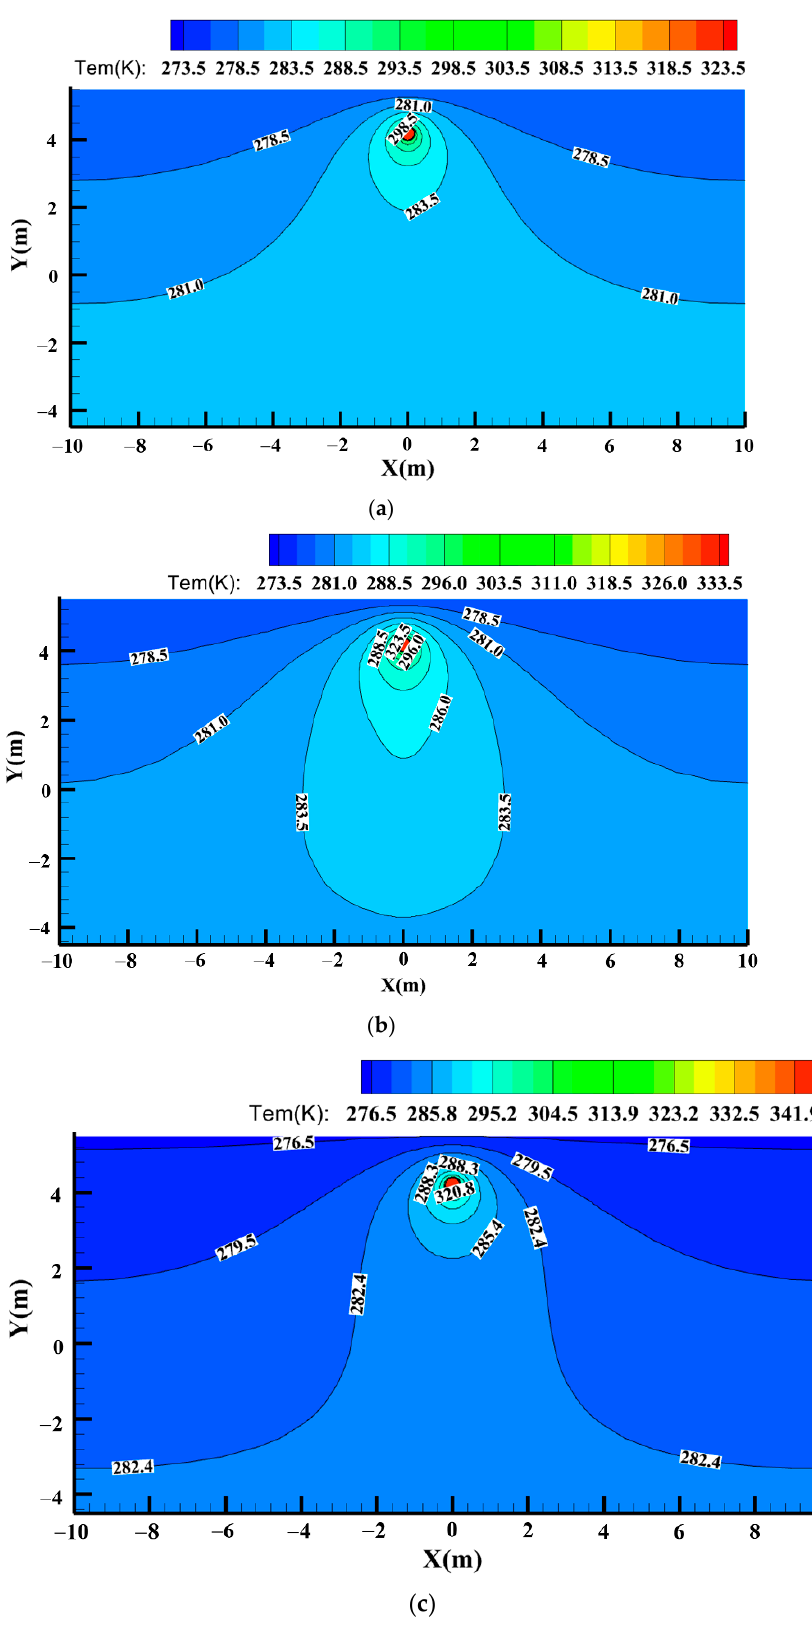
Figure 9. Temperature field on the cross section with different oil flow temperature. at ( a ) 323 K, ( b ) 332 K and ( c ) 341 K.